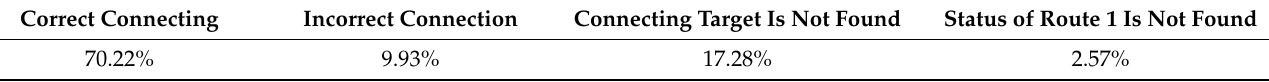
Table 2. Accuracy of connecting